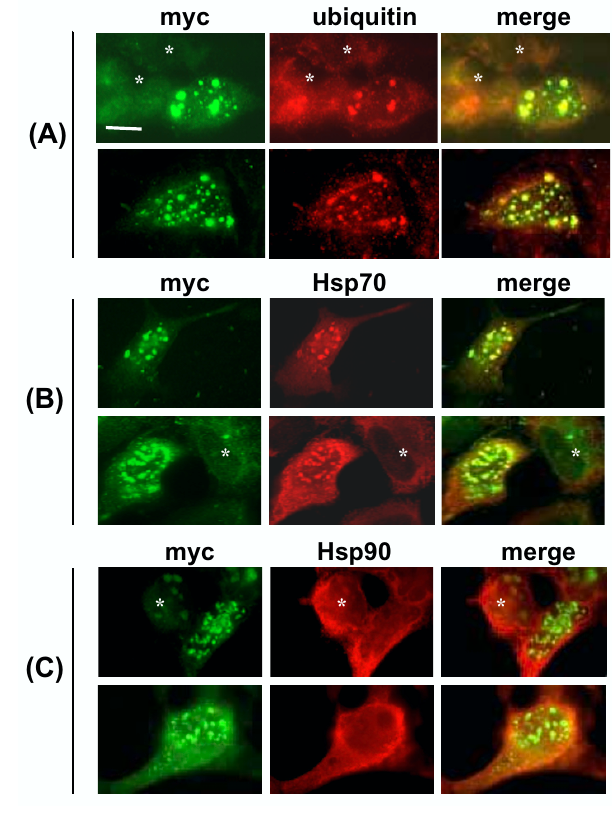
Figure 10 Localization of ubiquitin and Hsp70 in Rab24(D123I)- induced inclusions. HEK293 cells expressing mycRab24(D123I) were processed for immunofluorescence microscopy 24 h after transfection. In all panels, the myc- tagged Rab protein was detected with polyclonal antibody against the myc epitope followed by FITC-conjugated GAR IgG. Cells were co-stained with mouse monoclonal antibod- ies against (A) ubiquitin, (B) Hsp70/Hsc70 or (C) Hsp90, fol- lowed by rhodamine-conjugated GAM IgG. Non-transfected cells (no myc staining above background) are marked with asterisks in each panel. The bar represents 10